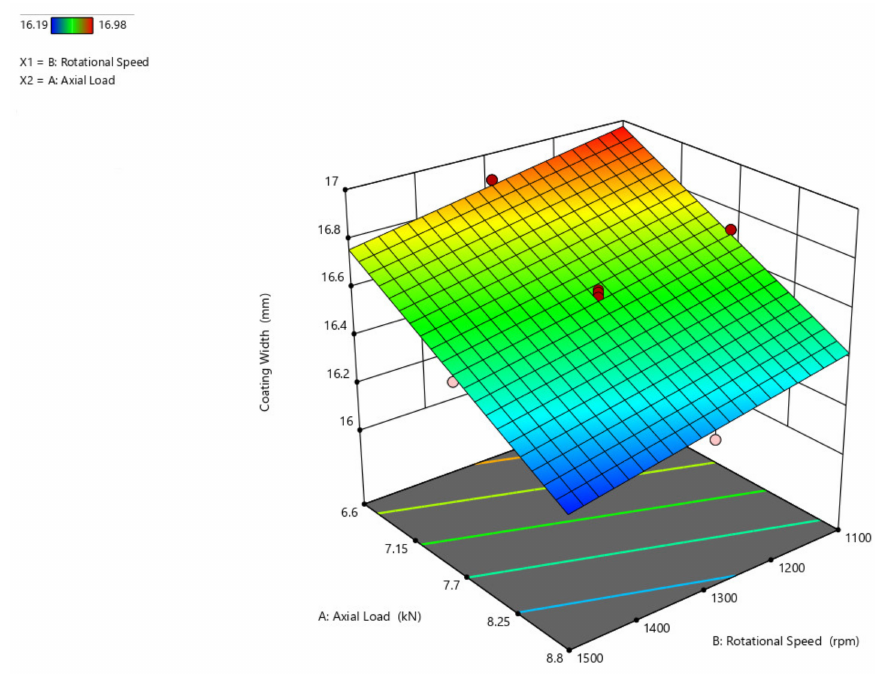
Figure 8. Interaction plot of rotational speed and axial load on coating width (C w